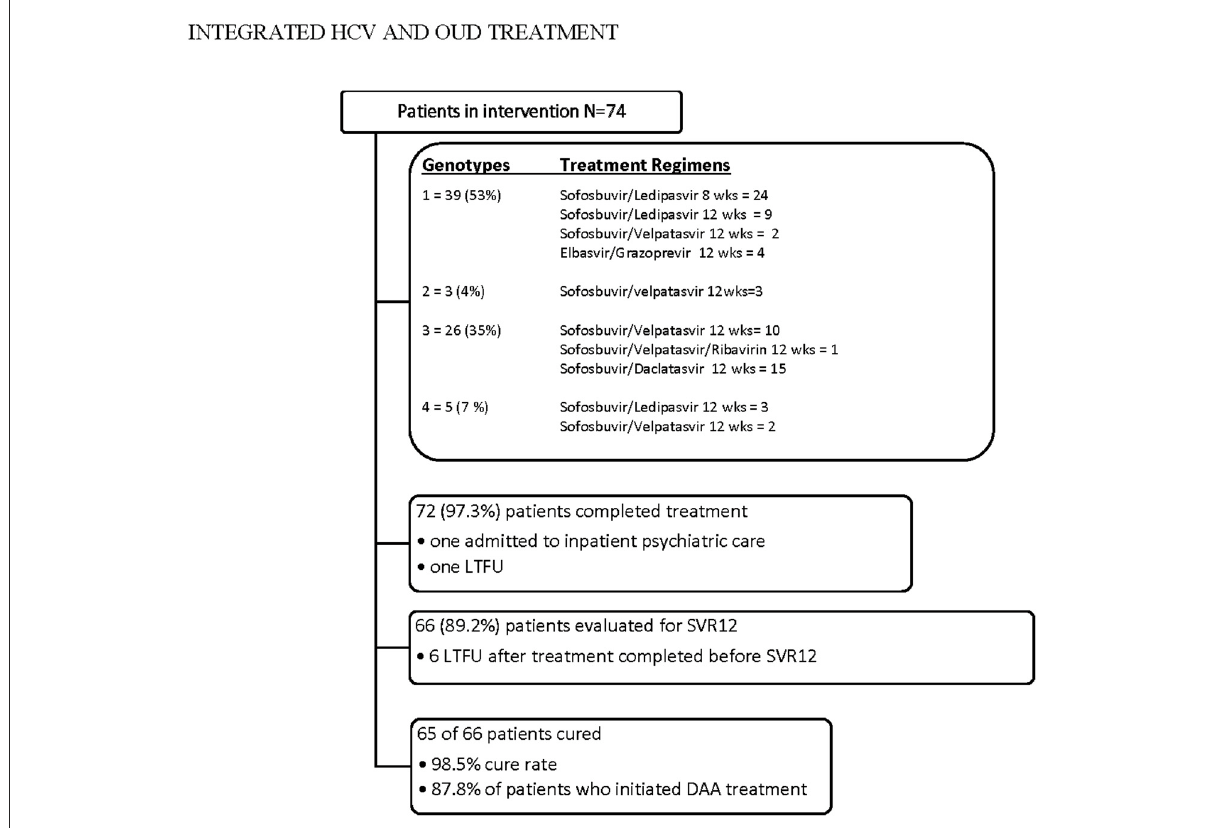
FIGURE1 Patient treatment